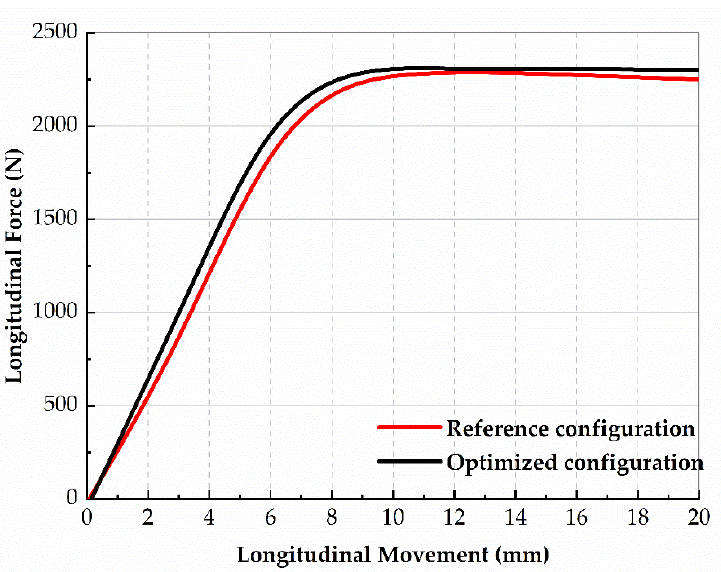
Figure 20. Longitudinal stiffness of the reference and optimized configurations. Table 7. Values of the design and response variables (reference and optimized